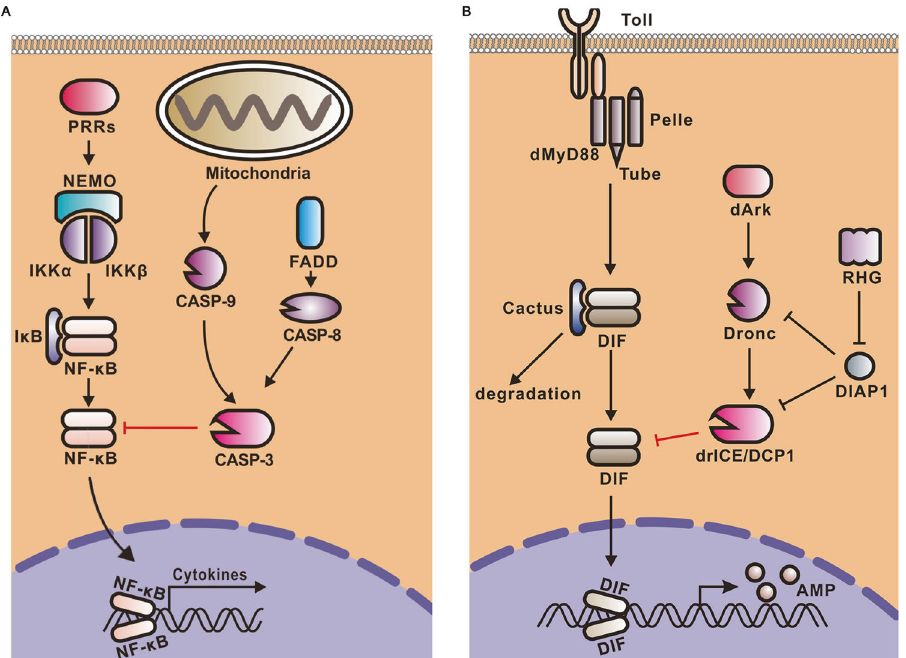
Fig. 6 Models for the negative regulation of NF- κ B signaling pathways by caspase-3-mediated cleavage of NF- κ Bs. A In mammals, apoptotic effector caspase-3 cleaves of NF- κ B members p65/Rel A, RelB, and c-Rel resulting in a comprehensive repression of both NF- κ B signaling pathways, which is proposed to act as a self-protective mechanism to prevent overreactive innate immune responses. B In Drosophila, apoptosis mediates the proteolysis of DIF, the NF- κ B of Toll pathway, resulting in the repression of Toll immune signaling, dependently of the effector caspases drICE and